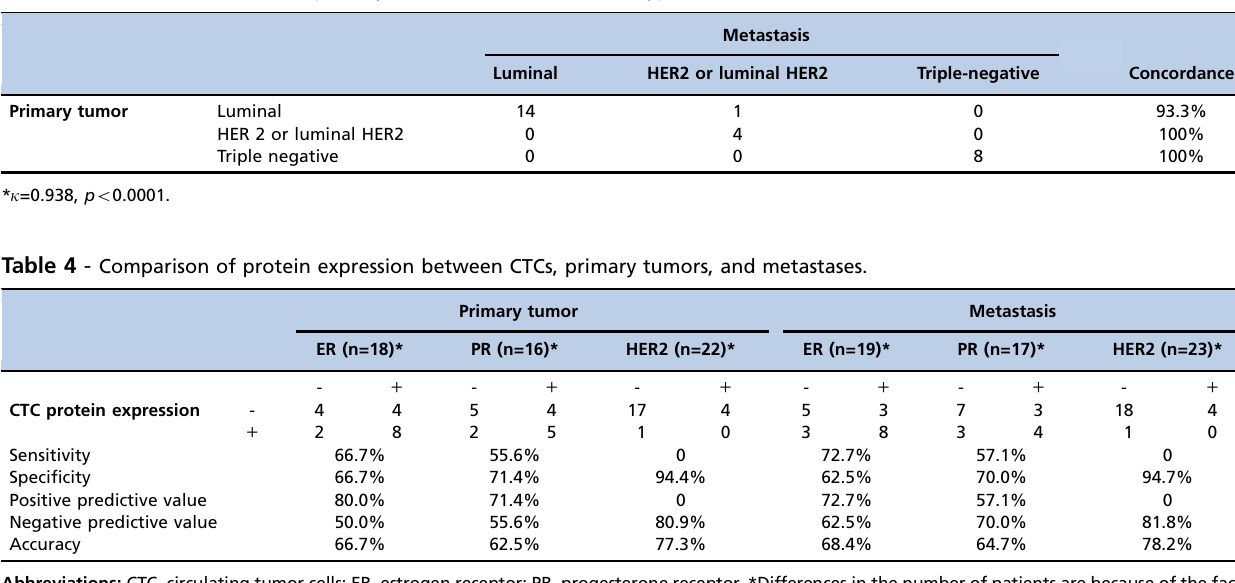
Table 3 - Concordance between primary tumors and metastasis subtypes.*